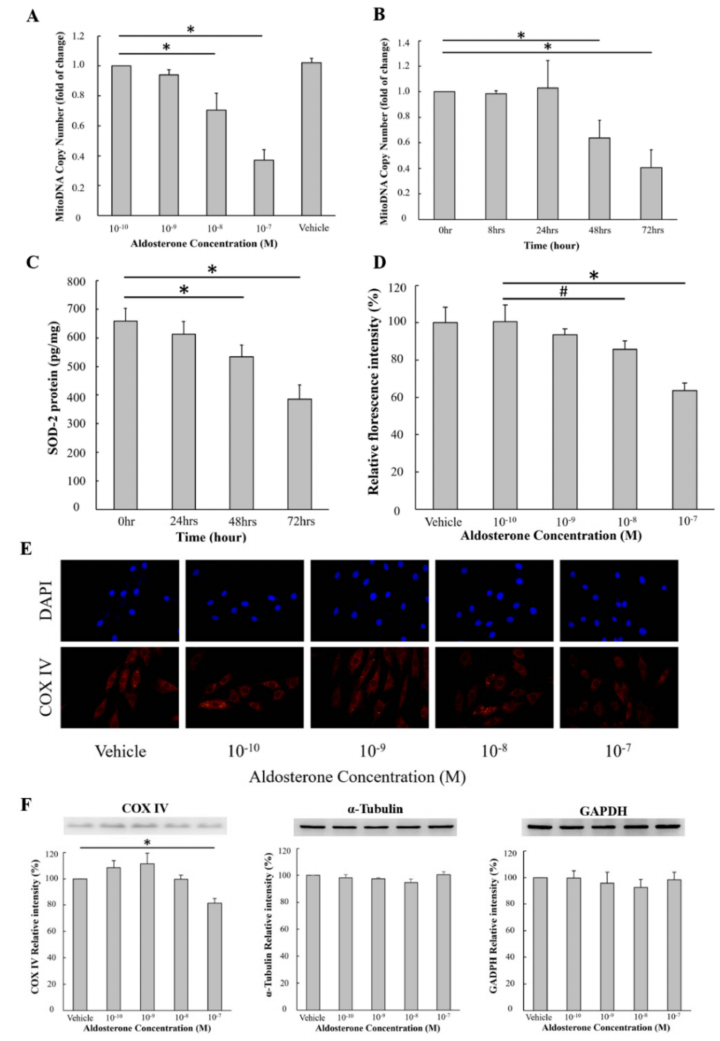
Figure 1. Aldosterone suppressed mitochondrial DNA and protein in a dose-dependent manner. ( A ) The effects of different dosages of aldosterone on H9c2 cells. H9c2 cells were treated with different concentrations of aldosterone (10 − 10 , 10 − 9 , 10 − 8 and 10 − 7 M) and vehicle (equal volume of DMSO) for 72 h. The mitochondrial DNA copy number was quantified by qPCR. ( B ) The effects of different durations of aldosterone treatment on H9c2 cells. H9c2 cells were treated with 10 − 7 M aldosterone and the mitochondrial copy number was quantified by qPCR at 0, 8, 24, 48 and 72 h. ( C ) The effects of different durations of aldosterone treatment on SOD2. H9c2 cells were treated with 10 − 7 M aldosterone, and the expression of SOD2 was determined by ELISA. ( D ) The dose effect of aldosterone on mitochondrial COX IV protein. H9c2 cells were treated with different concentrations of aldosterone (vehicle, 10 − 10 , 10 − 9 , 10 − 8 and 10 − 7 M) for 72 h. COX IV was stained with anti-COX IV antibodies. The fluorescence intensity of COX IV was measured using a fluorescence microscope. ( E ) H9c2 cells were treated with different concentrations of aldosterone (10 − 10 , 10 − 9 , 10 − 8 and 10 − 7 M) for 72 h. COX IV was stained with anti-COX IV antibodies (red), and nuclear DNA was